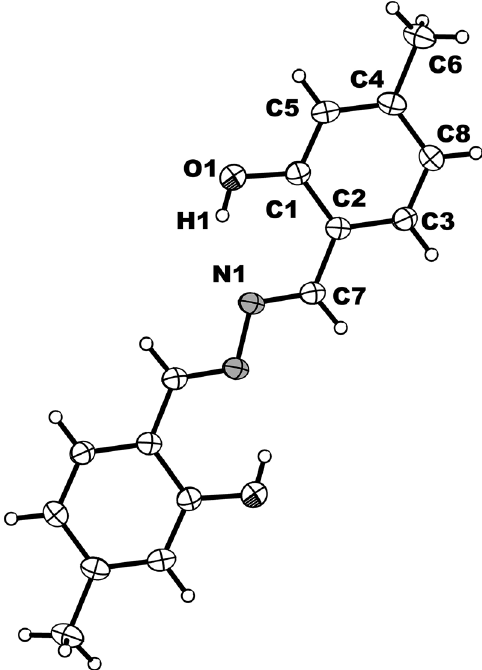
Table  : Data collection and